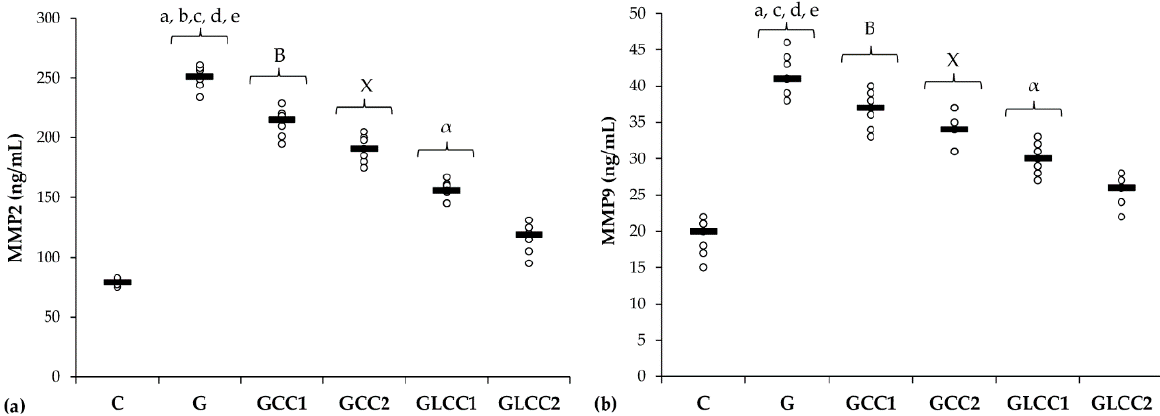
Table 3. Serum levels of matrix metalloproteinases.